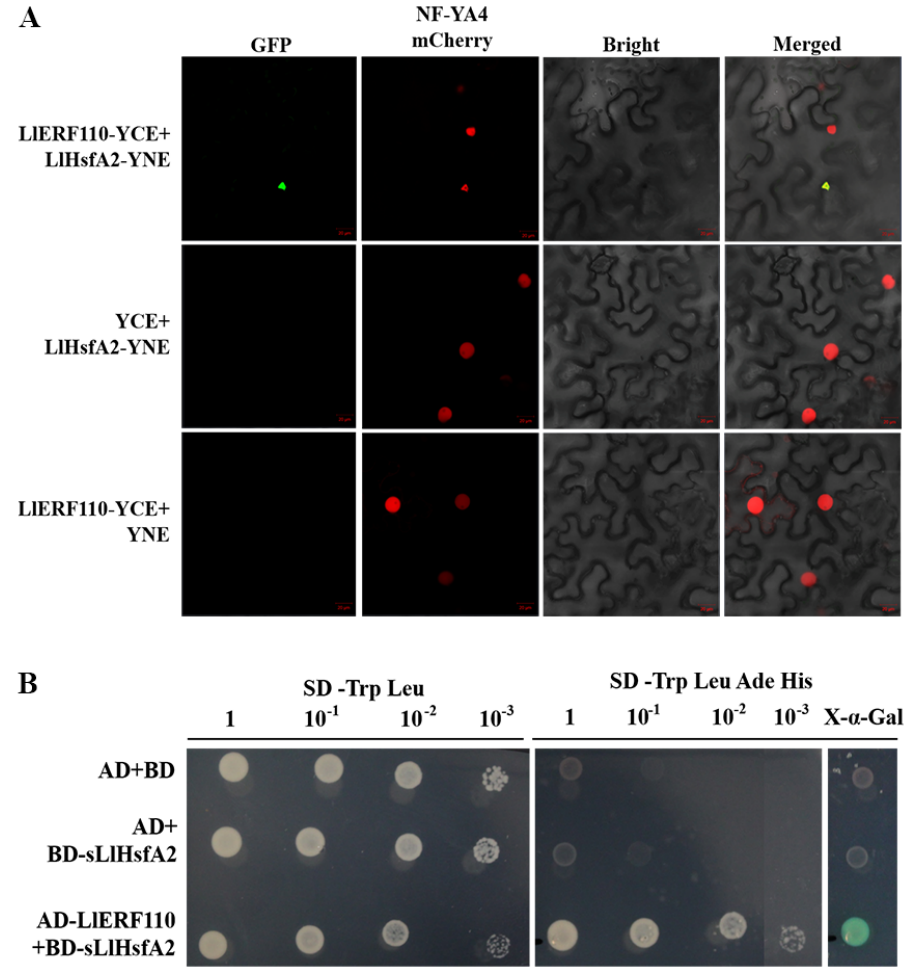
Figure 8. LlERF110 interacts with LlHsfA2. ( A ) BiFC assay. The plasmid LlERF110 − pSPYCE (YCE) and HsfA2 − pSPYNE (YNE) were co − infiltrated into the N. benthamiana leaves with the nuclear marker NF − YA4 − mCherry, respectively. LlERF110 − YCE together with YNE, HsfA2 − YNE together with empty vector YCE were used as negative controls. Green and red fluorescence were visual- ized by confocal microscopy 72 h after infiltration. Bars = 20 µm. ( B ) Y2H assay. The empty vector pGADT7(AD) + pGBKT7 (BD) and pGADT7(AD) + BD − sLlHsfA2 was used as two negative con- trols. The transformed yeast cells were grown in an SD medium with or without adenine and his- tidine. Cultured yeast cells were diluted to different concentrations of 10 − 1 , 10 − 2 and 10 − 3 to test their growth vitality. X −α− gal staining was used for the detection of β− gal activity of yeast without di- lution.